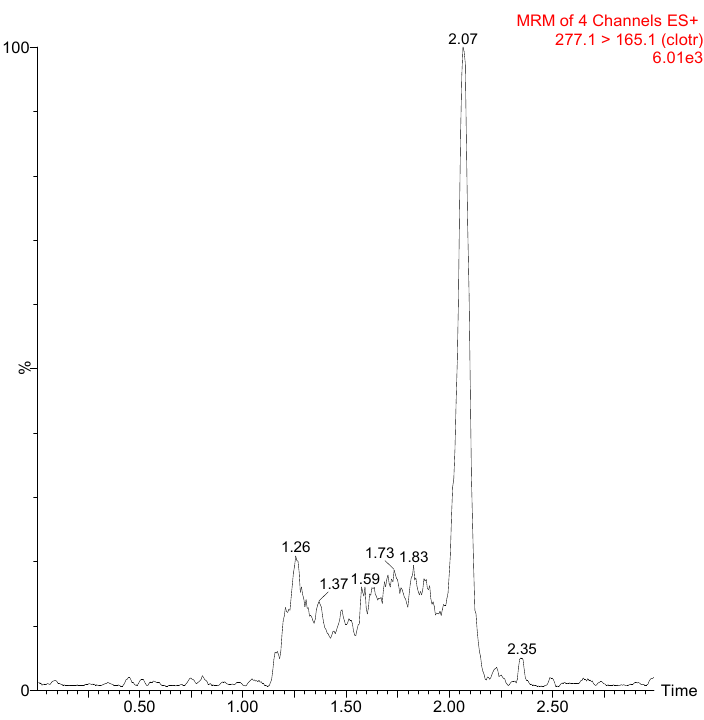
Figure 3. Chromatogram indicating 0.488 ng/mL of CTZ in plasma sample.